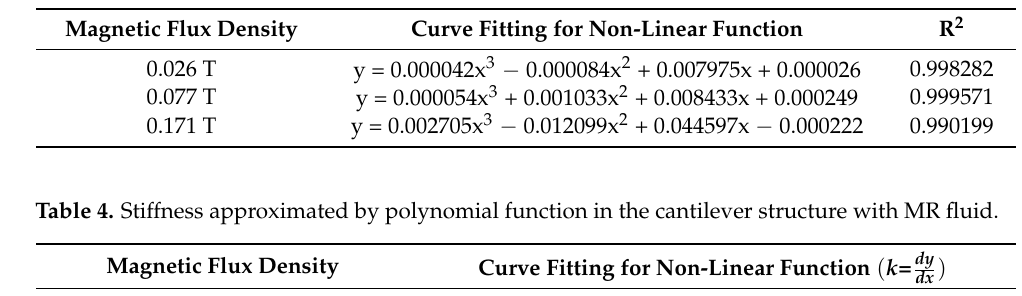
Table 3. Load–displacement relationship approximated by polynomial function in the cantilever structure with MR fluid.